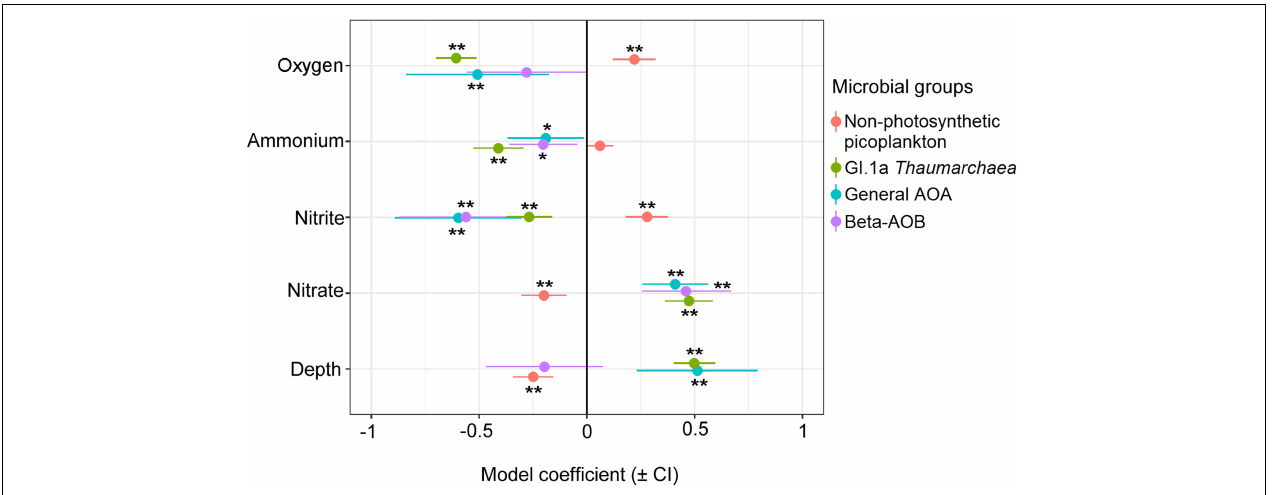
FIGURE 5 | Coefficient plot of prokaryote community in response to physical-chemical variables. Error bars represent confidence intervals. Significance are indicated by asterisks (i.e., * P < 0.05; ** P <